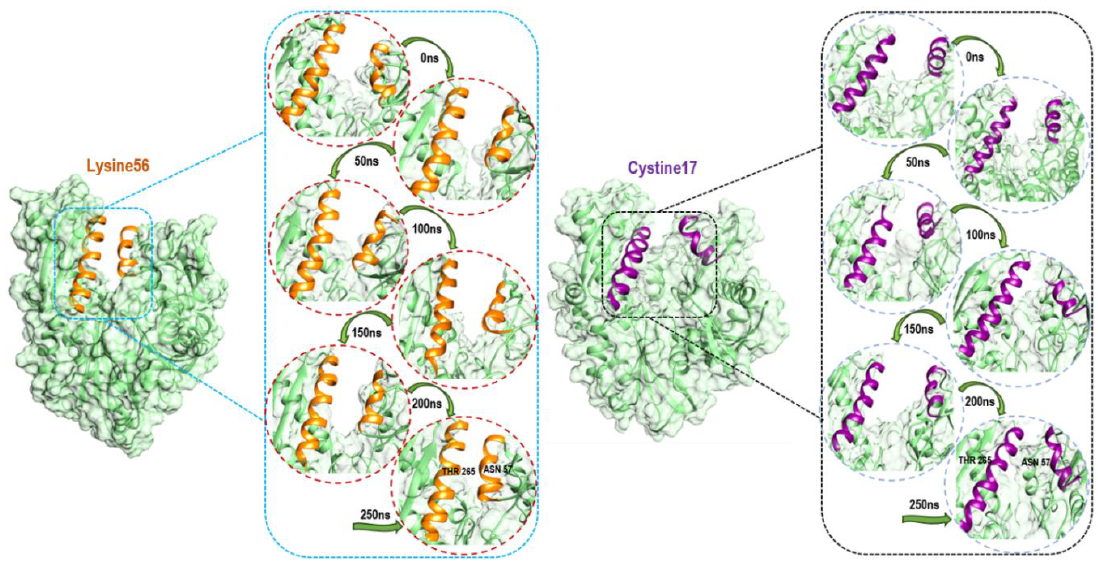
Figure 8. Conformational dynamic comparison of α-helix coupling upon 8- N -benzyladenosine binding to Lys56 ( Orang color ) and Cys17 ( violet color ) showing the closed conformation of HSP71-NBD.